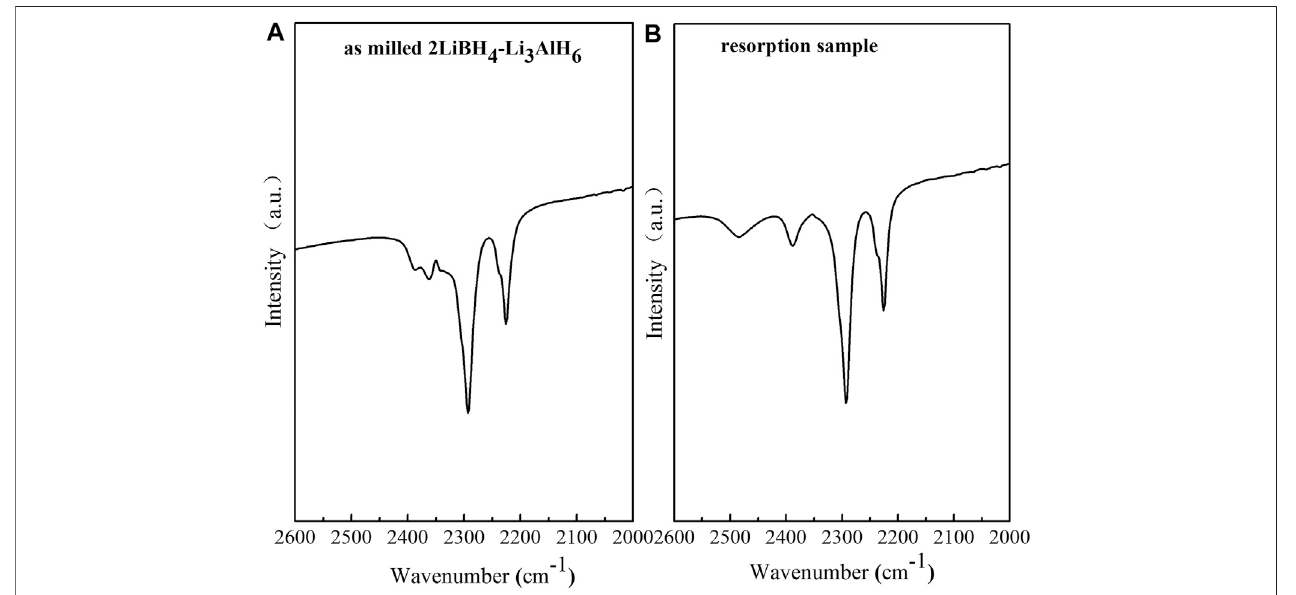
FIGURE 7 | FT – IR curves of the 2LiBH 4 – Li 3 AlH 6 samples: (A) after ball-milling and (B) rehydrogenation.